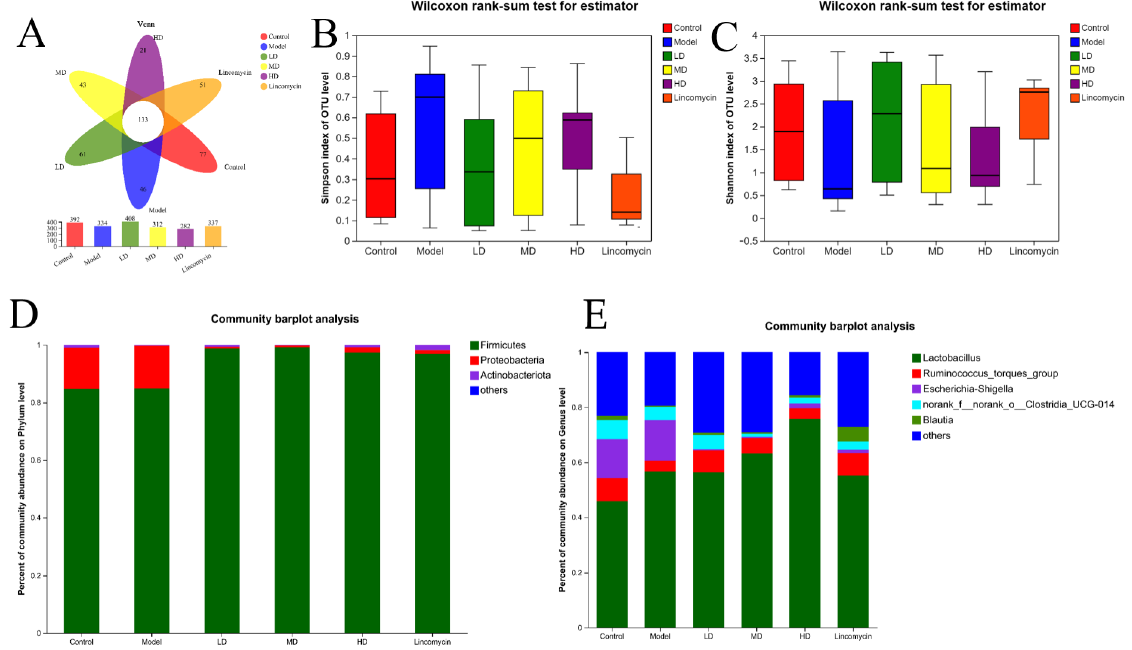
Figure 9. 16S rRNA sequencing results. ( A ) Venn diagram; ( B ) Simpson index; ( C ) Shannon index; ( D ) differences at the phylum level; ( E ) differences at the genus level.